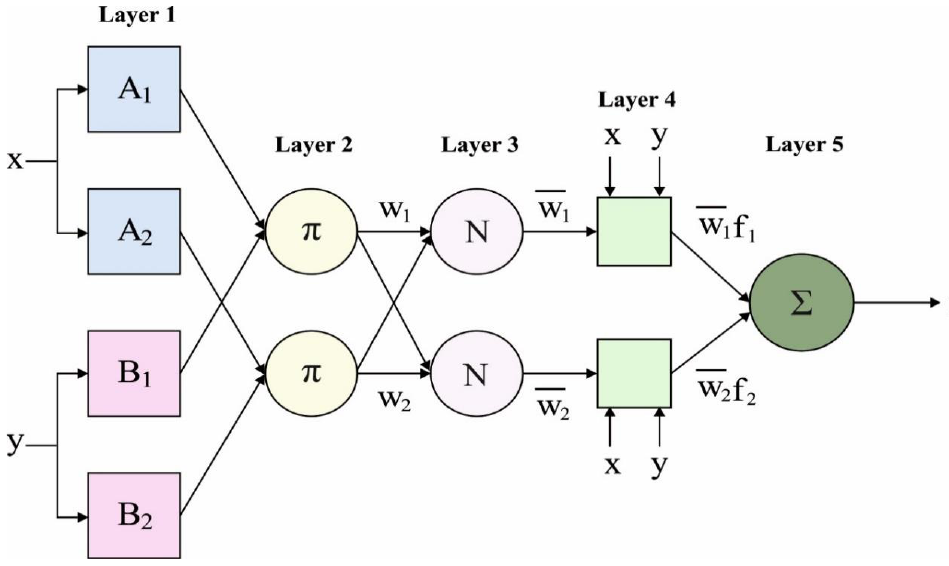
Figure 3. ANFC structure.